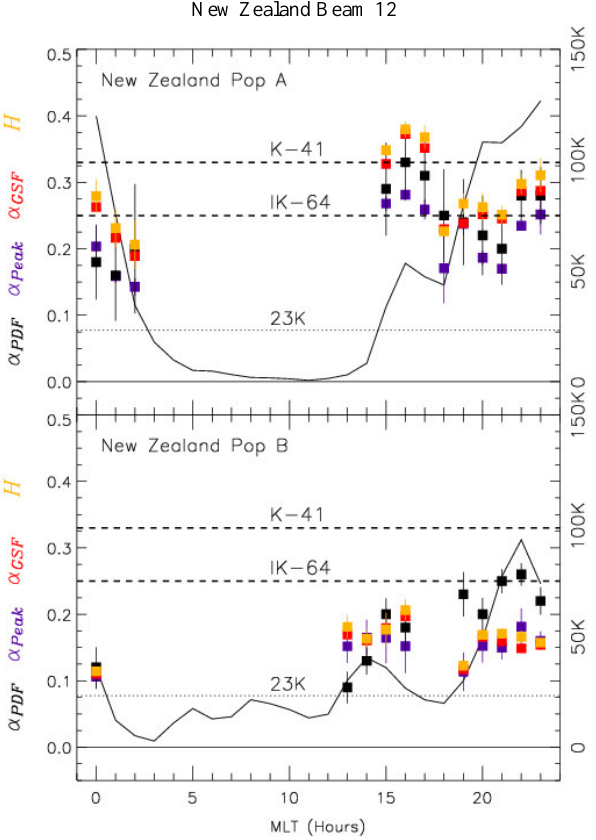
Fig. 10. (a) The same as in Fig. 9 except for Population A echoes measured using New Zealand beam 12. (b) The same except for Population B echoes.